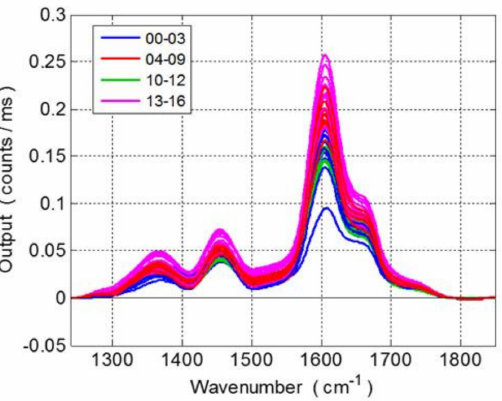
Figure 3. Baseline and corrected Raman spectra (1240–1850 cm − 1 ) of the entire ZA grape seed collection during the overripening process (16 days of postharvest sun